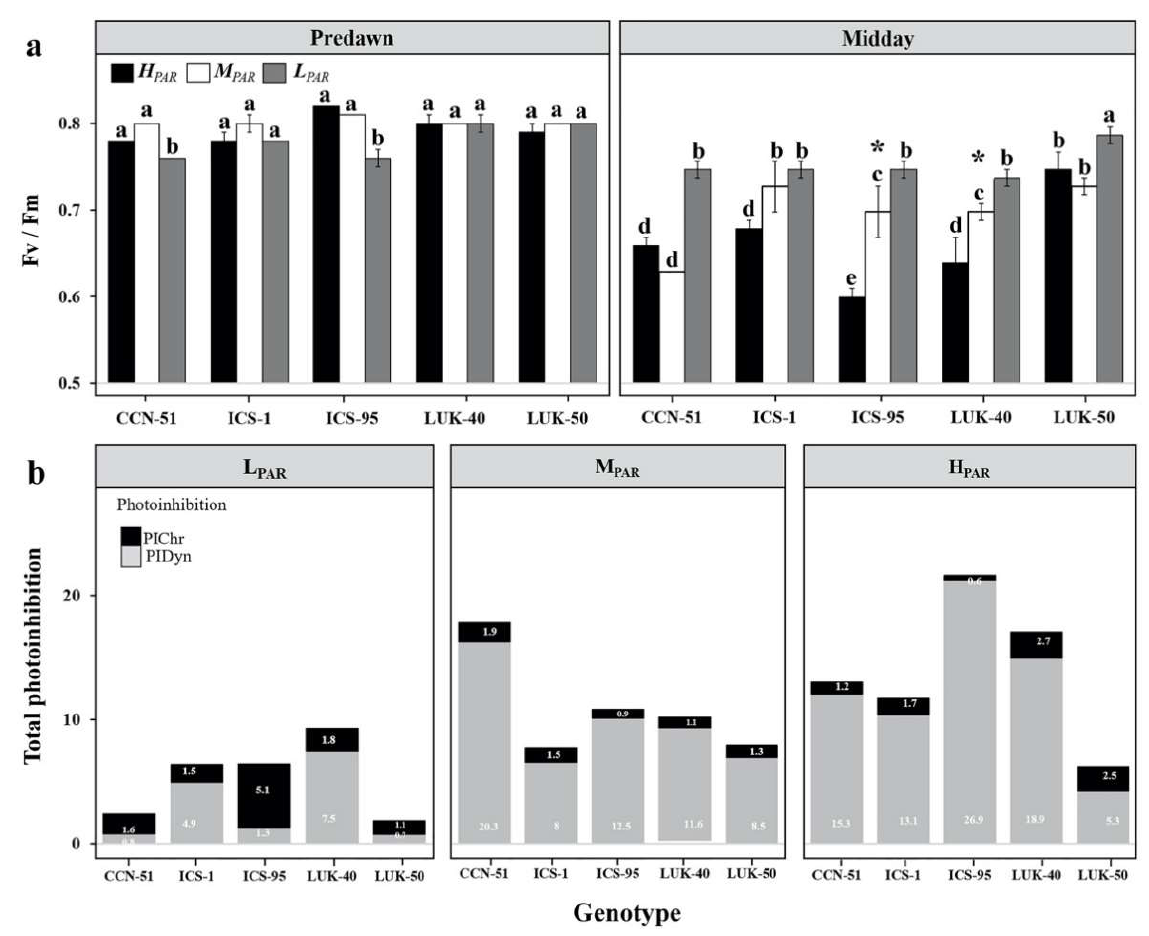
Figure 4. Parameters of chlorophyll a fluorescence analysis in five cocoa genotypes under different levels of radiation. ( a ). maximum quantum yield of PSII (F v /F m ), ( b ). photoinhibition indices of the PSII. Chronic PSII photoinhibition (PIChr). Dynamic PSII photoinhibition (PIDyn). a,b,c : Values in bars with different letters indicate significant differences between genotypes of cacao × radiation level (post hoc LSD Fisher, p < 0.05). *: Means the statistical differences between the radiation levels in each of the cocoa genotypes at the different evaluation times. The results include means ± SE ( n = 4). Statistics are defined as in Figure 1.